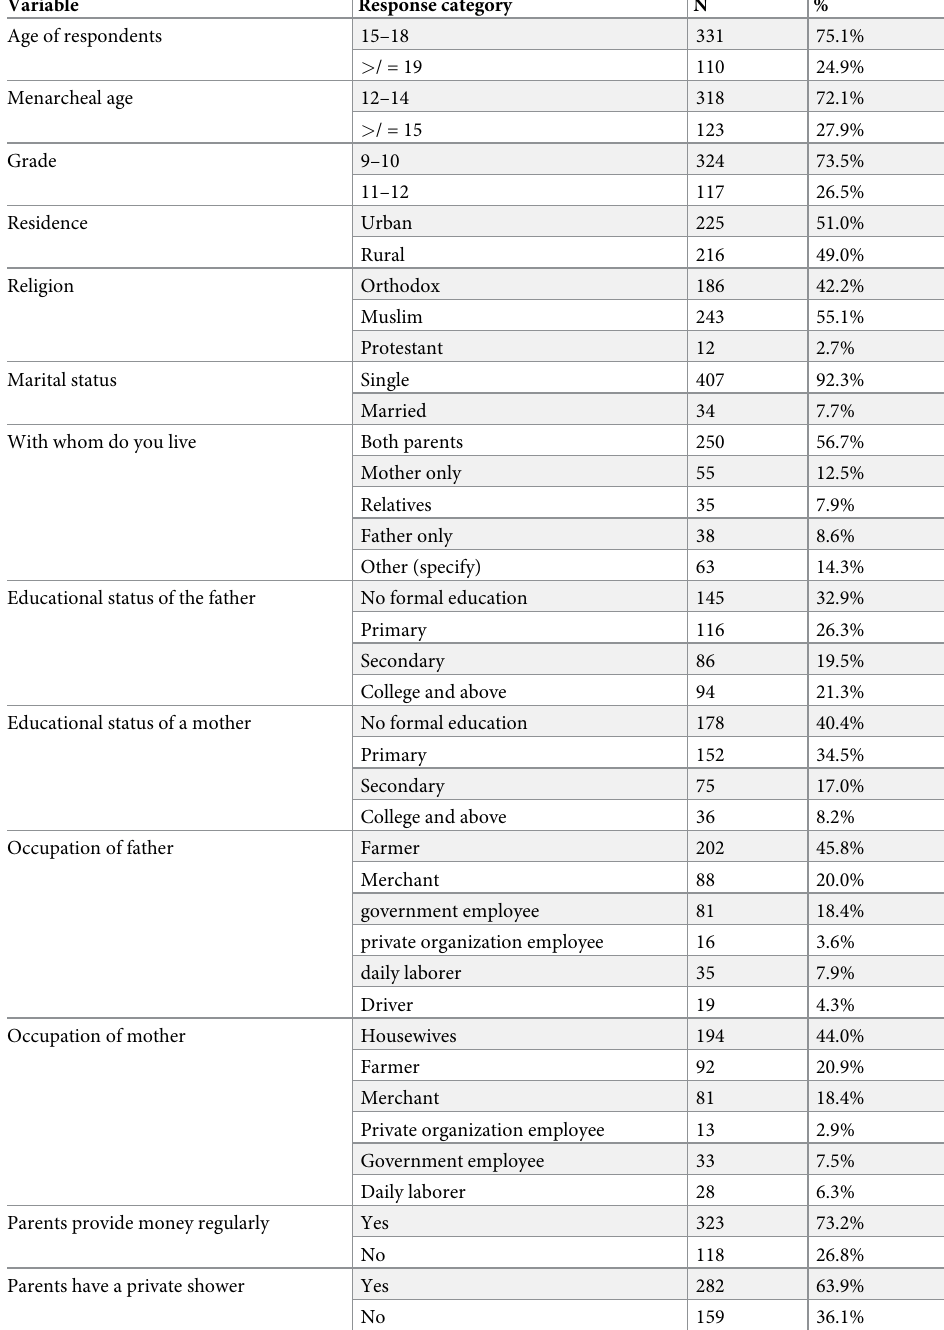
Table 1. Participants Socio-demographic, family-related characteristics in Mekdela secondary school girls, Amhara Regional State, Northeast Ethiopia, 2020 (n =